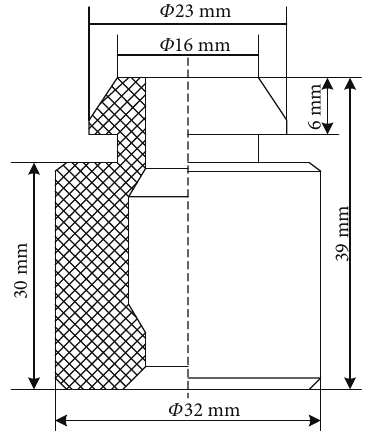
Figure 4: The structure of the RIP.